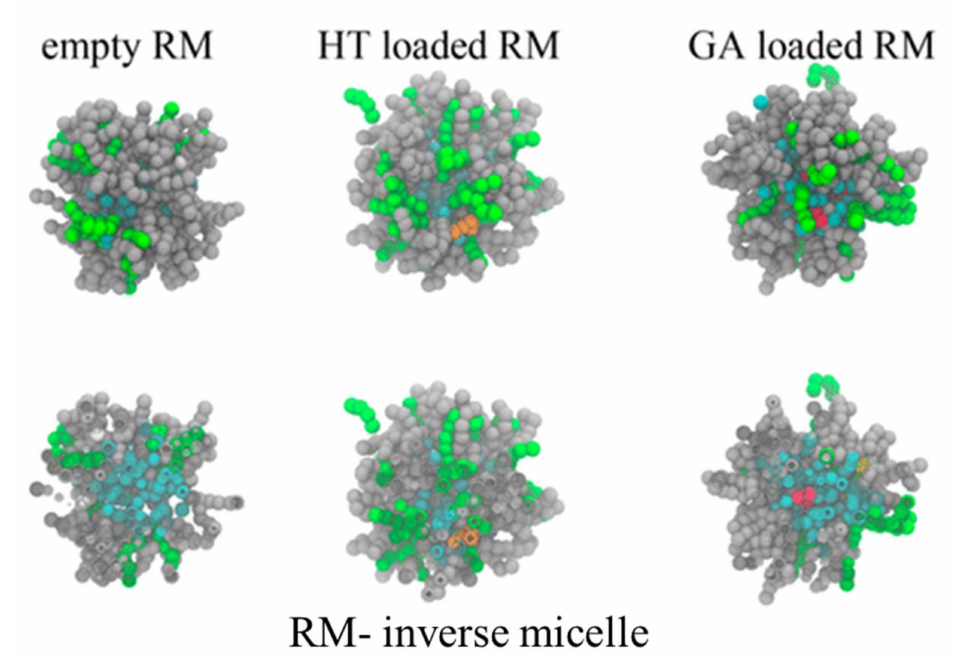
Figure 10. IT-147 clusters of inverse micelles produced by the simulation study: empty RM (without antioxidant), HT-loaded RM, and GA-loaded RM are antioxidant-loaded RMs. Reprinted with permission from [81]. Copyright 2016 American Chemical Society.